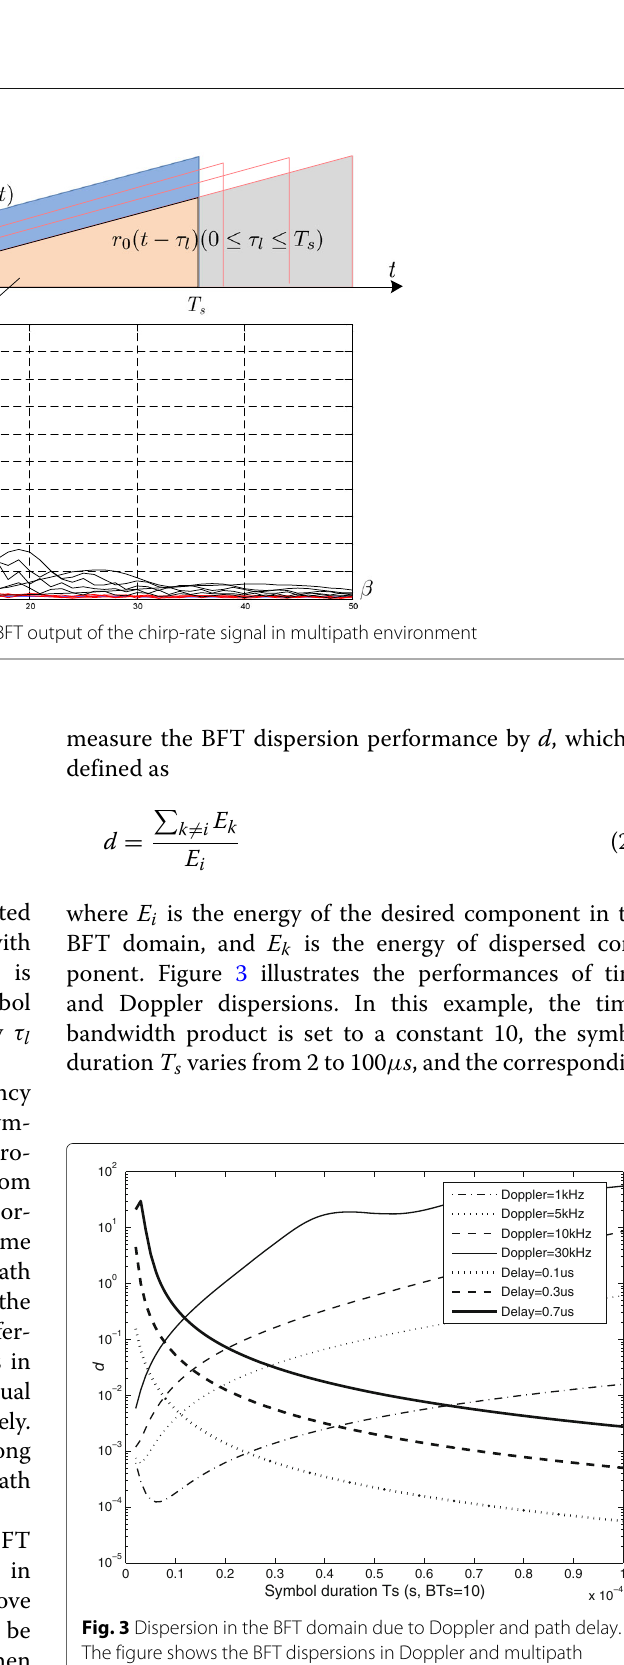
Fig. 3 Dispersion in the BFT domain due to Doppler and path delay. The figure shows the BFT dispersions in Doppler and multipath environment with different signal